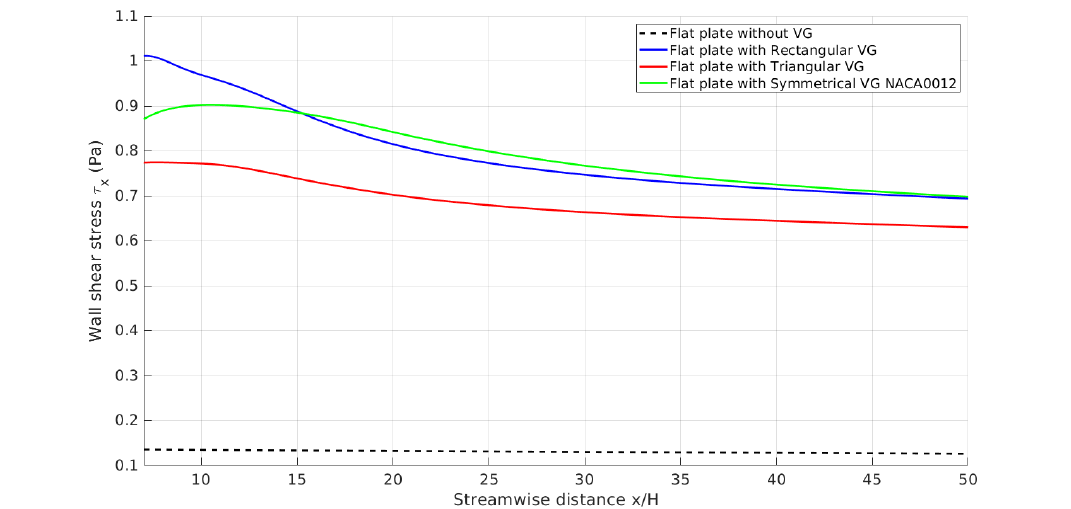
Figure 16. Streamwise wall shear stress τ x development in (Pa). Value for flat plate case without vortex generator in dash